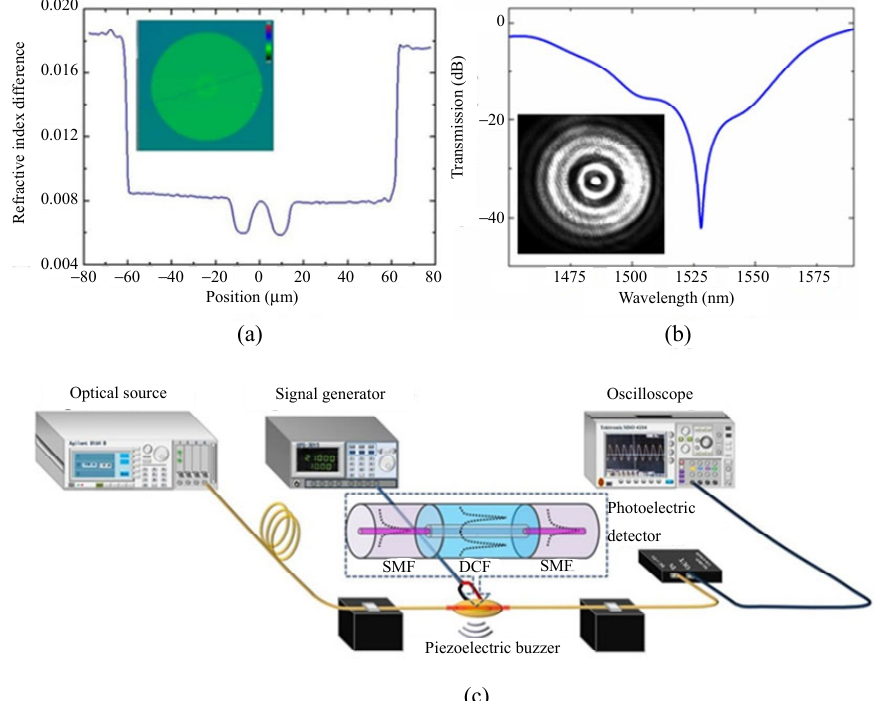
Fig. 2 Characterization of the DCF-based sensor: (a) measured refractive index profile of DCF with the picture shown in the inset; (b) transmission spectrum of 13-mm-long DCF, and the inset shows the LP 05 mode profile of DCF captured by the charge coupled device (CCD) with an input wavelength of ~1530 nm; (c) experimental setup of an acoustic vibration sensing system: DCF and